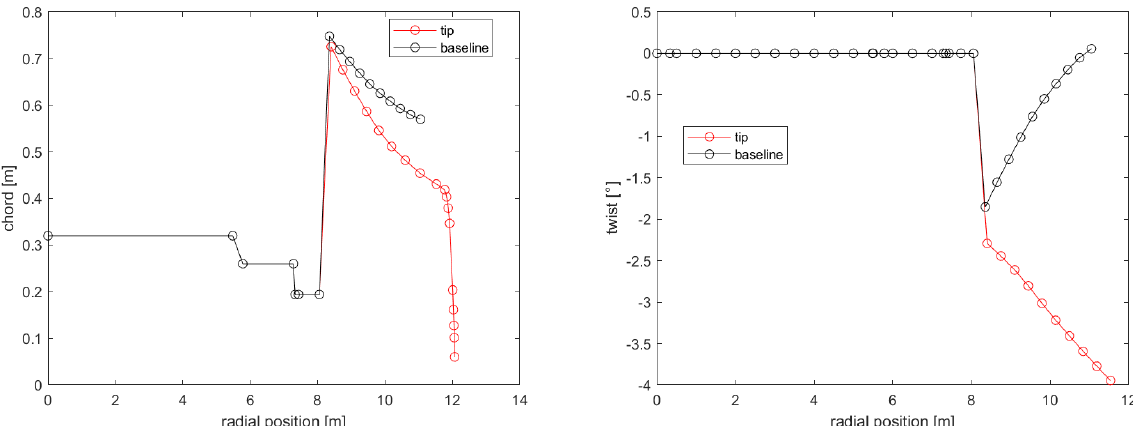
Figure 3. In-plane and out-of-plane coordinate of the centerline of the optimized tip design compared to the reference.